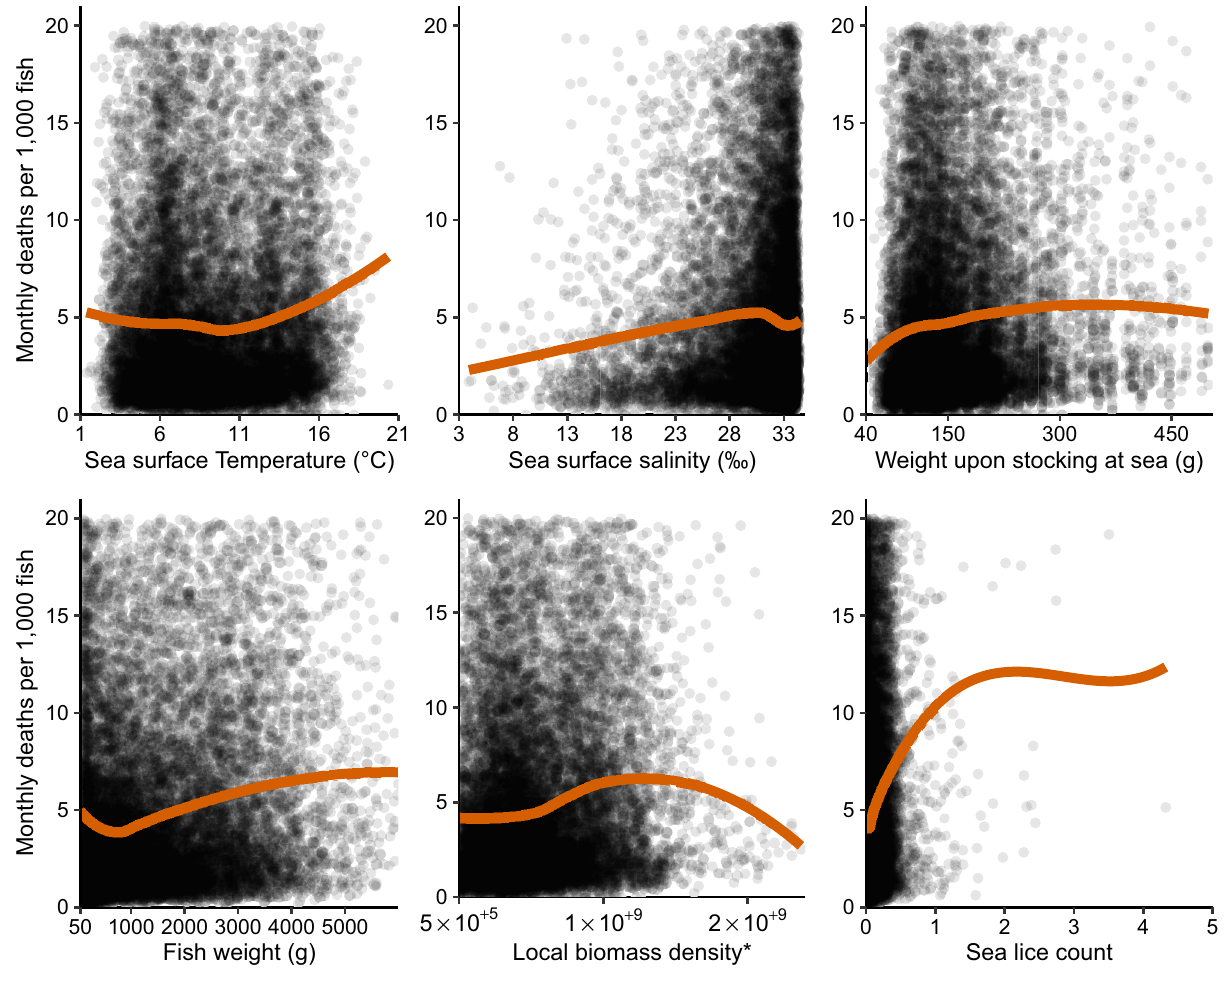
Figure 2. Scatter plots with fitted local polynomial regression (LOESS) curves of mortality versus continuous explanatory variables. *The local biomass density (LBD) of a farm in a certain month is a summarized record of Atlantic salmon biomass (i.e. number of fish multiplied by mean weight) calculated using data from neighboring farms located up to 40 km seaway distance. For full details on LBD calculations, we refer to Jansen et al. 38 . This figure was generated using the Tidyverse 46 and gridExtra 48 packages in R 47